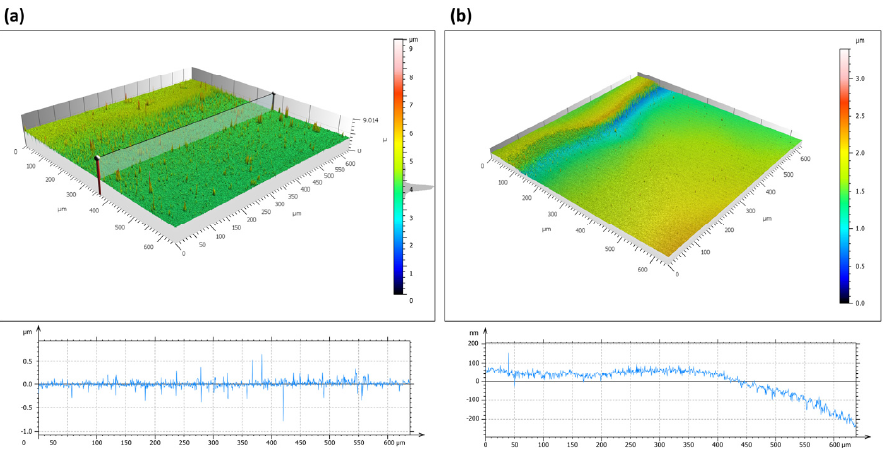
Figure 8. Three ‐ dimensional morphology and line profile curves: ( a ) coating; ( b ) substrate. Figure 8. Three-dimensional morphology and line profile curves: ( a ) coating; ( b )